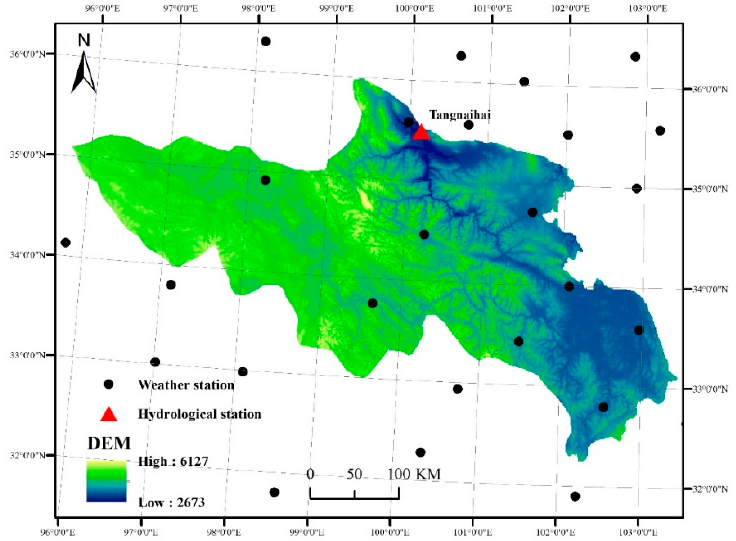
Figure 1. Location of hydrological and weather stations in and around the SRYR.